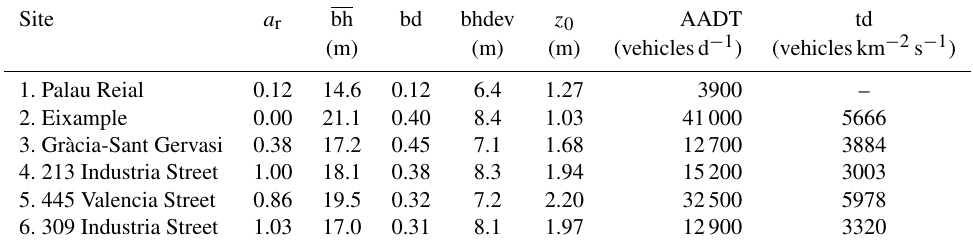
Table 3. Morphometric and traffic description of measurement sites used in CALIOPE-Urban evaluation. The measurement height of the official network sites and the mobile sites is 3m. AADT from the nearest street is considered. The traffic density (td) is estimated following Eq. (9). The Palau Reial td is not included because it is an urban background site not directly exposed to high traffic.